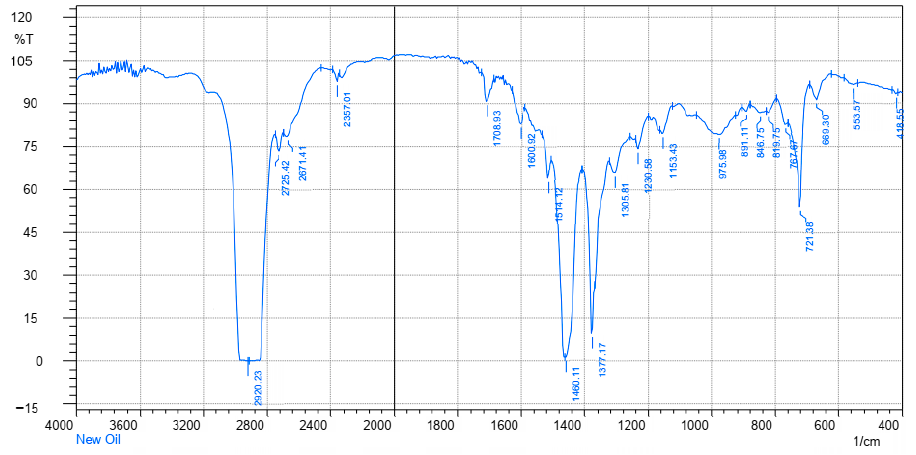
Figure 7. IR spectra of the new oil. Table 2. Analyses of IR spectra (new oil).